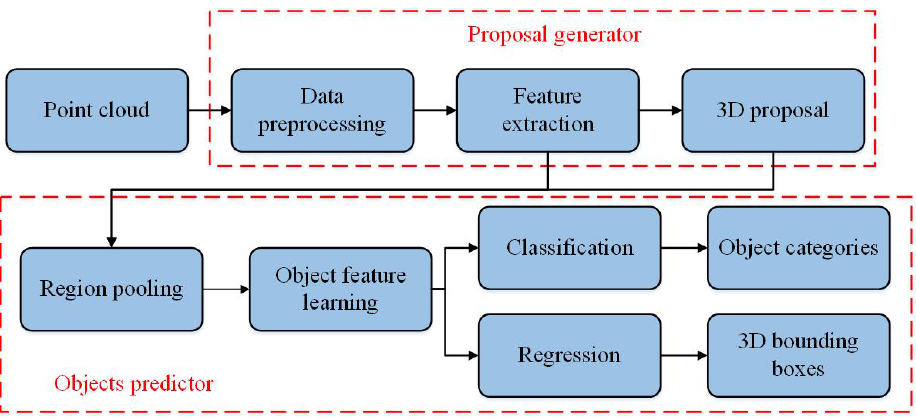
Figure 7. The flow chart of two-stage detection.